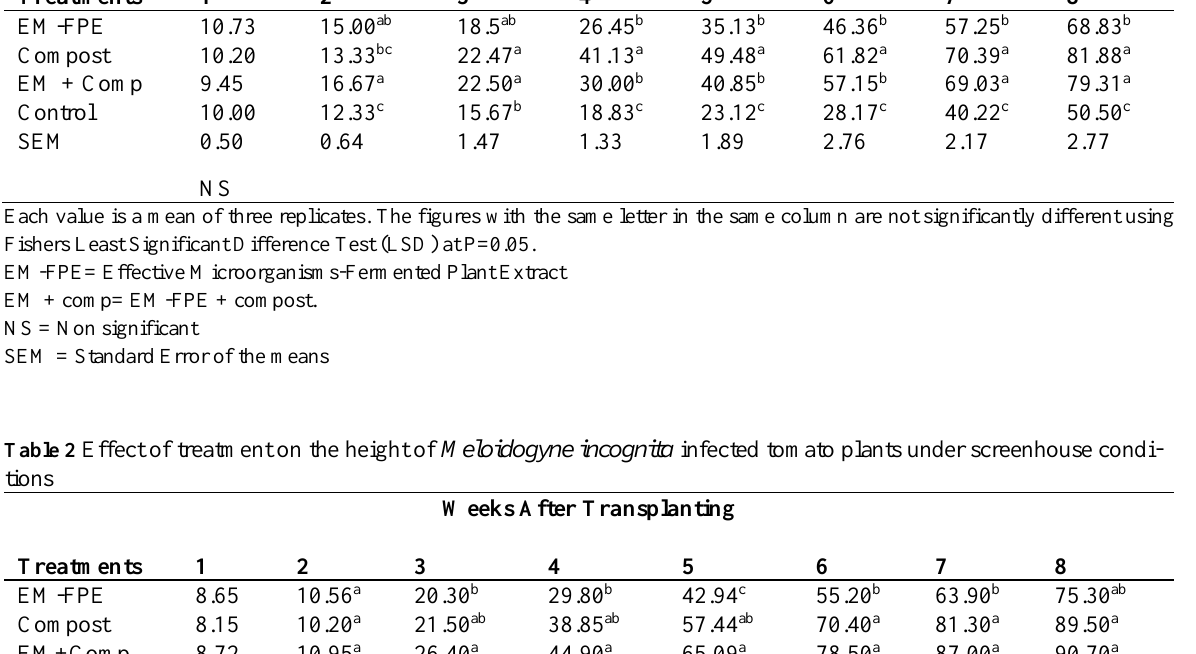
Table 1 Effect of treatment on the height of Meloidogyne incognita infested tomato plants under field conditions Weeks After Transplanting Treatments